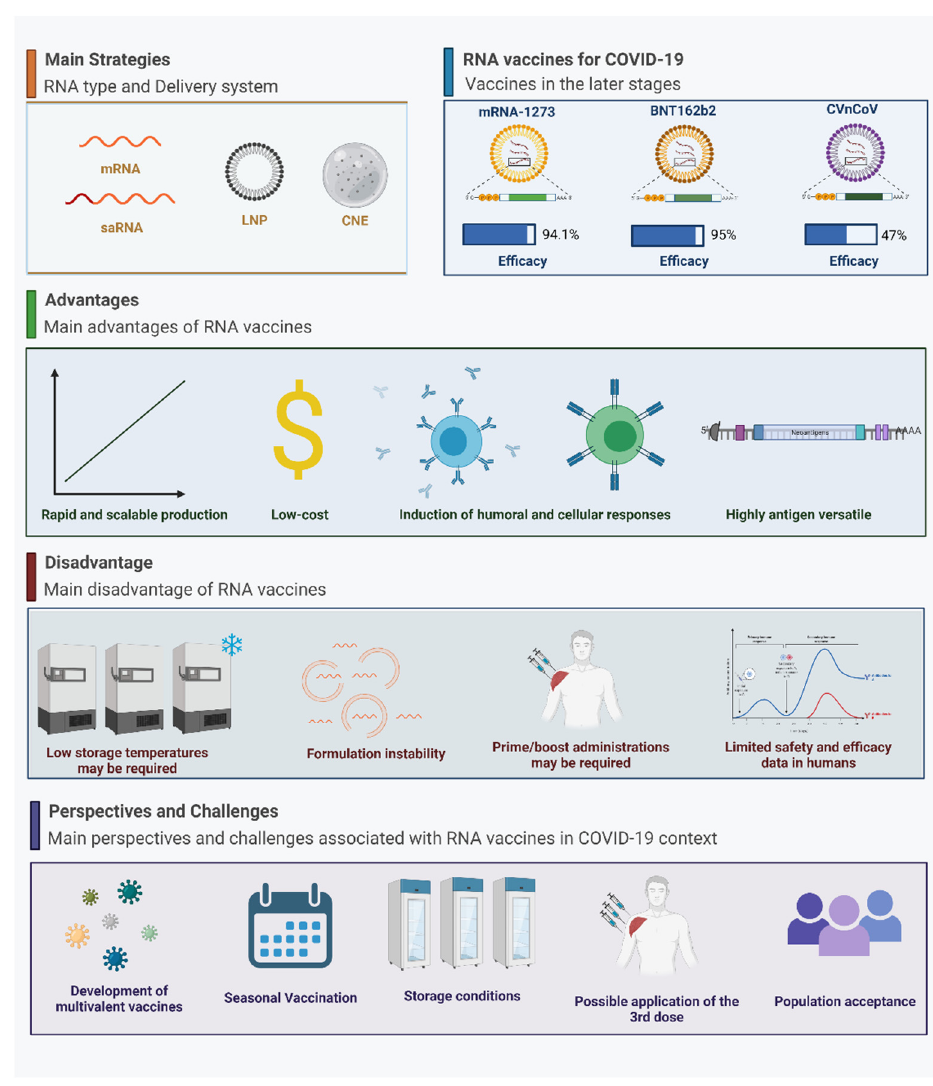
Figure 2. Perspectives and challenges for RNA-based vaccines for COVID-19. Created with BioRender.com (accessed on 30 September